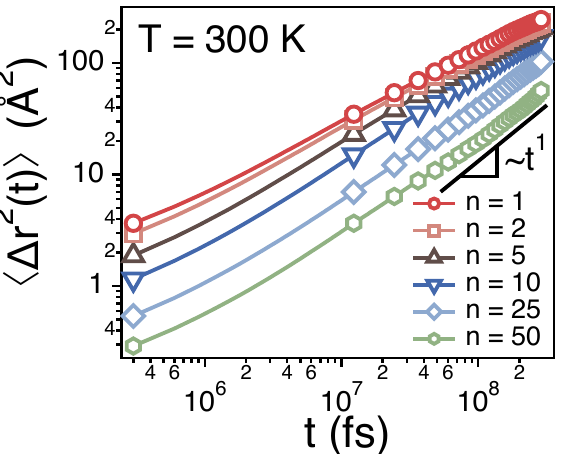
Figure 4. Simulation results for the mean-square displacements ( (cid:104) ∆ r 2 ( t ) (cid:105) ) of the centers of mass of strands of size n at T = 300 K. The statistical errors are smaller than the